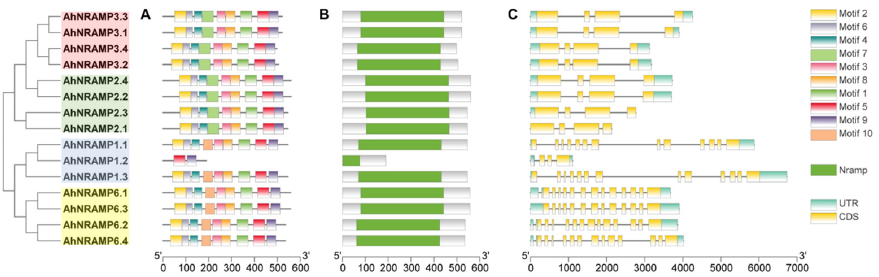
Figure 2. Conserved motifs ( A ) and domains ( B ) in AhNRAMP proteins as well as exon-intron structure ( C ) of AhNRAMP genes from peanut. UTR and CDS represent untranslated regions and coding sequences, respectively.